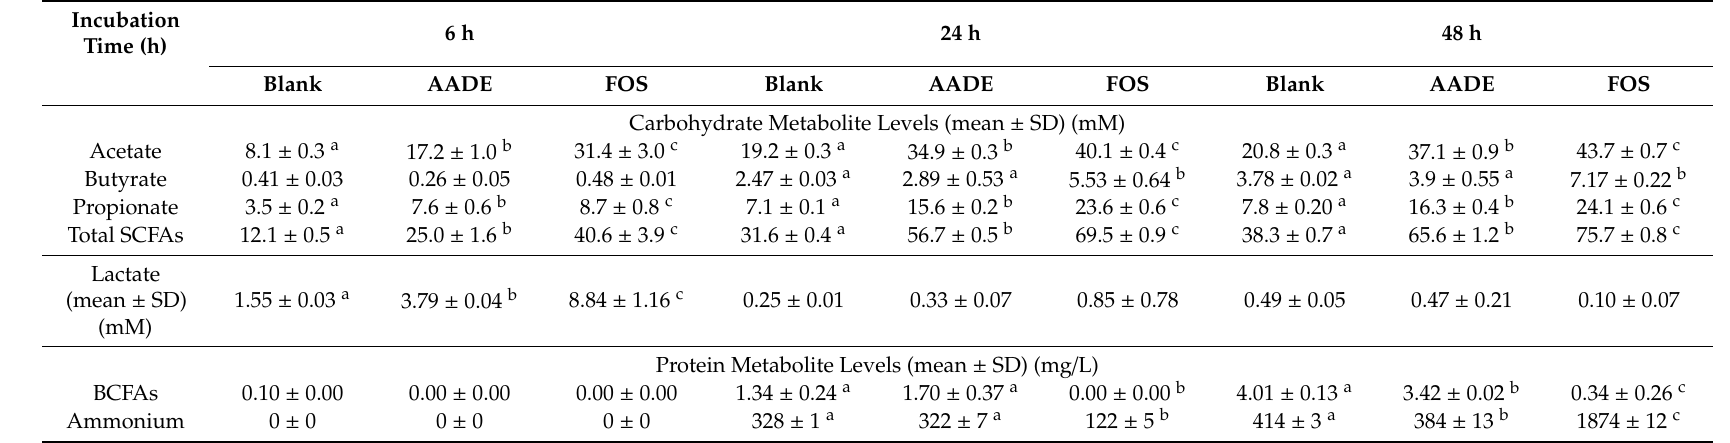
Table 4. Mean ( ± standard deviation) carbohydrate- and protein-derived metabolites after 0, 24, and 48 h of treatment of a simulated colonic microbiota with 5 g / L AADE (artichoke aqueous dry extract) or FOS (fructo-oligosaccharides). For each endpoint and within each time point (24 h or 48 h), a value indicated with a di ff erent letter (a, b, or c) indicates a statistical di ff erence between AADE, FOS and / or the blank, as tested with a two-way ANOVA with post-hoc Tukey test ( p < 0.05). In contrast, when at least one letter is shared between two treatments, there was no significant between these